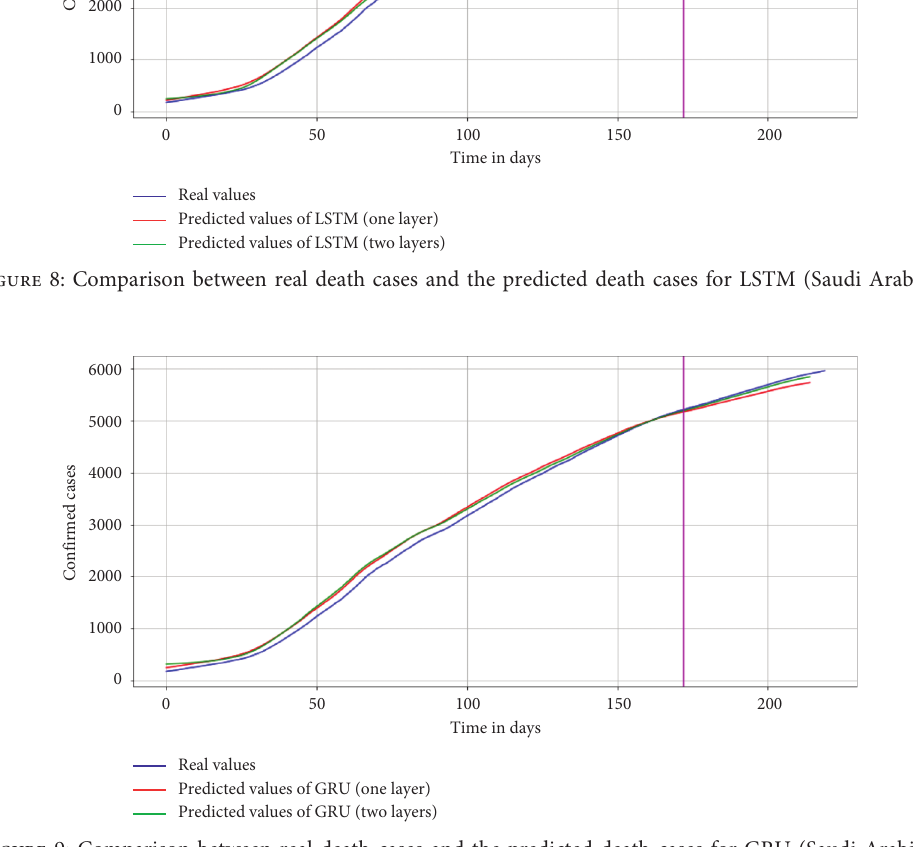
Figure 9: Comparison between real death cases and the predicted death cases for GRU (Saudi